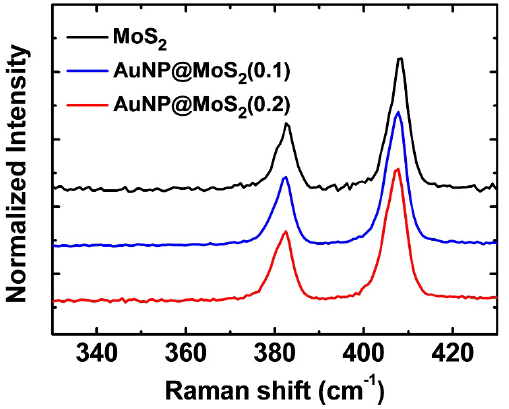
Figure 3. The Raman spectra of AuNP@MoS 2 nanocompositions. The concentrations of the Au ions were 0.1 and 0.2 ml mL − 1 ,